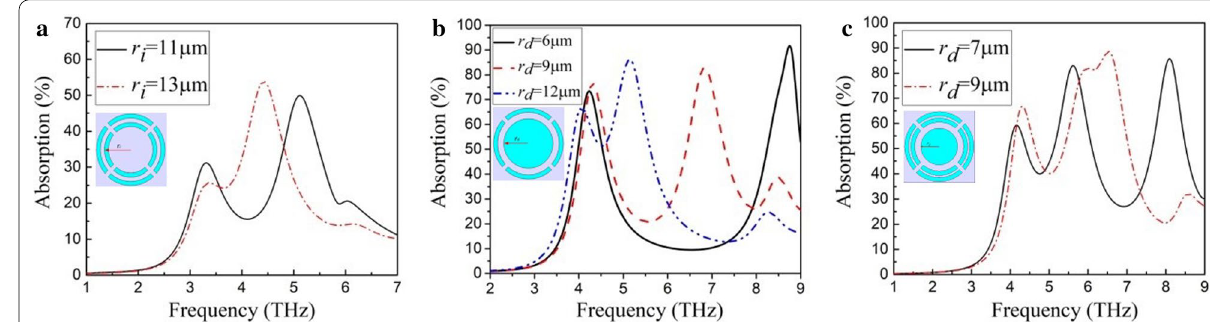
Fig. 3 a THz wave absorption of periodic dual-ring structures with different outer radii of the inner split-ring ( r i ). The dual-ring structures have an opening width of 2 μm and a thickness of 10 nm. The outer radius of the outer split-ring is 17 μm and the width of both split-rings is 2 μm. b THz wave absorption of periodic structures of a combination of a split-ring and an Al disk with different radii of the disk ( r d ). The periodic structures have a thickness of 10 nm. The split-ring has an outer radius of 17 μm, a ring width of 2 μm and an opening width of 2 μm. c THz wave absorption of periodic structures of a combination of two split-rings and an Al disk with different radii of the disk ( r d ). The periodic structures have a thickness of 10 nm. The two split-rings have a ring width of 2 μm, an opening width of 2 μm and an outer radius of 17 μm and 14 μm,